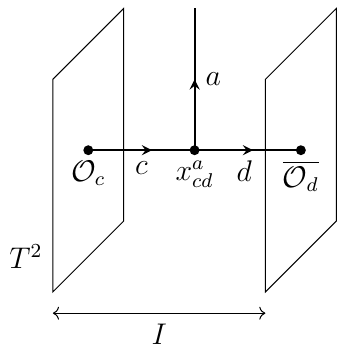
Figure 1 . States in the sector V c ⊗ V d ⊂ H a can be realized in the 3d TQFT description as in this figure. Associated with each end T 2 are holomorphic and antiholomorphic boundary conditions. Take operators O c and O d on the boundaries, corresponding to states in V c and V d , respectively. They are connected by topological lines labeled by c and d meeting in the middle. Choose x a ∈ Hom( a ⊗ d, c ) cd to fuse c and d into a . Then O a ; x = ( O c , O d , x a ) is the defect operator corresponding to a cd cd state in the sector V c ⊗ V d ⊂ H a (See footnote 15). The degree of freedom in choosing x a is cd dim Hom( a ⊗ d, c ) = N c , which leads to the multiplicity of the sector V c ⊗ V d in H a ad